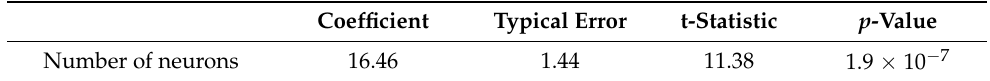
Table 10. Coefficients test.